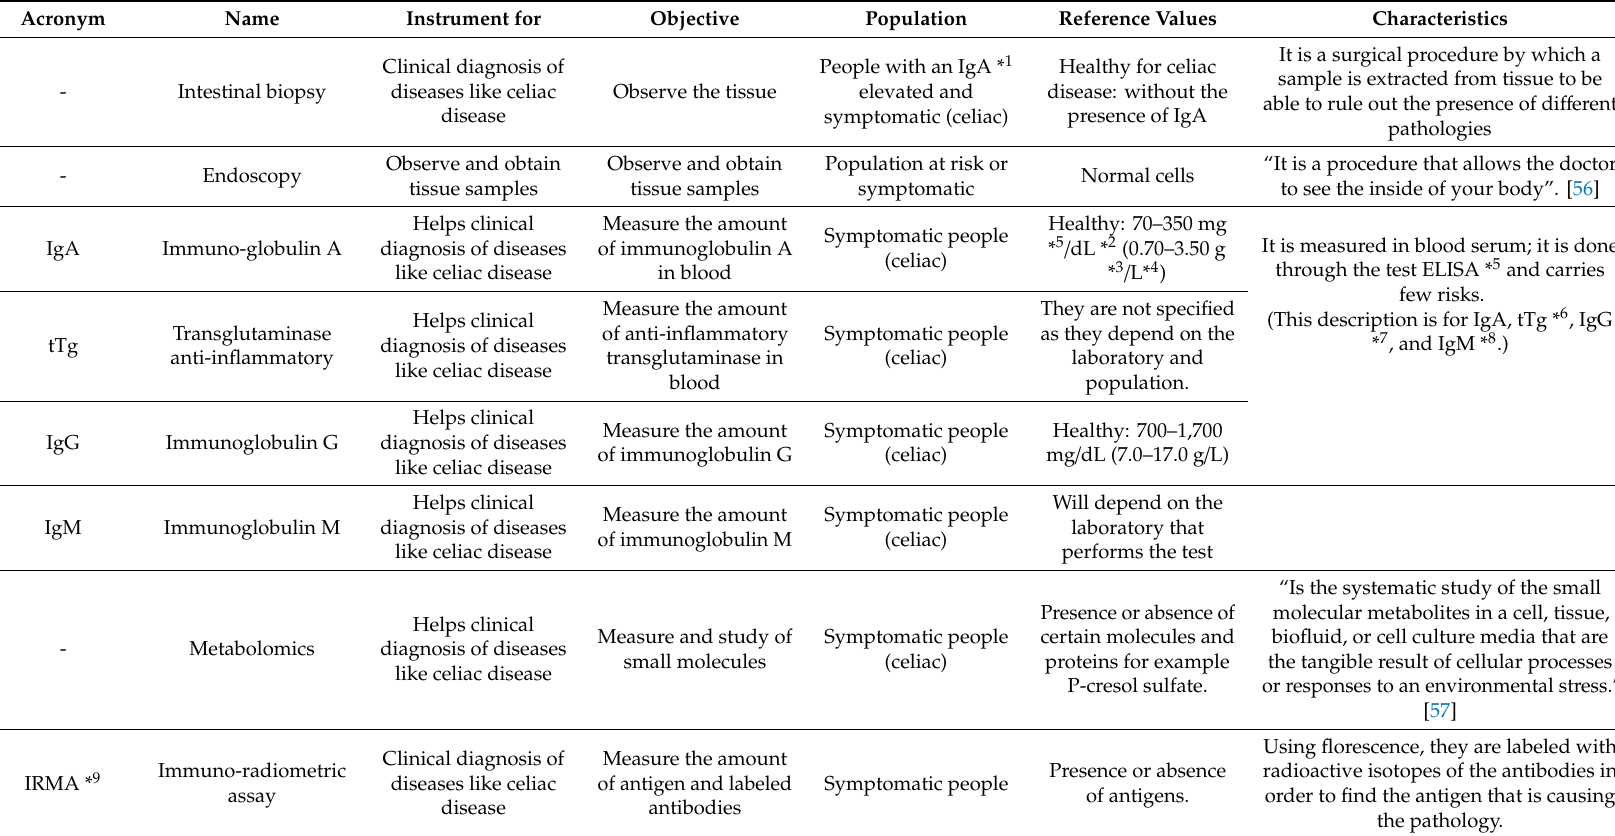
Table 2. Diagnostic tests (invasive) / description of the di ff erent analyses and tests performed on patients and for what they are